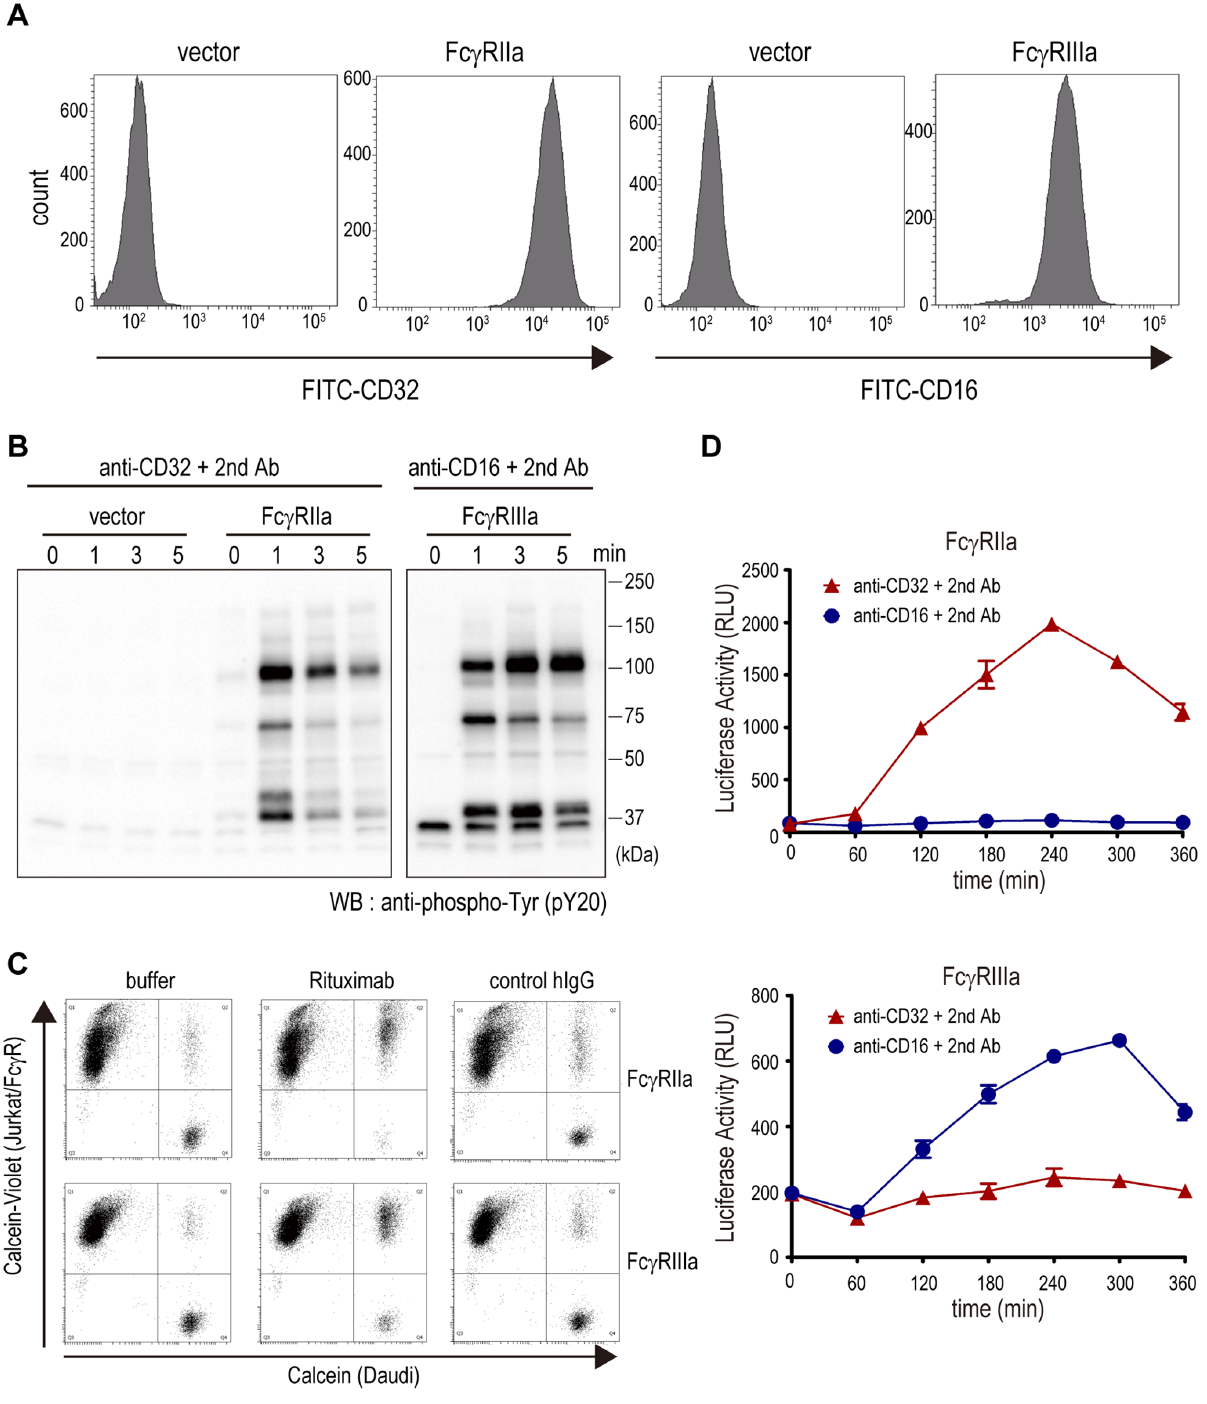
Figure 1. Establishment of the Fc c R-expressing reporter cell lines. (A) The cell surface expressions of Fc c Rs in Jurkat/Fc c R cells were analyzed by flow cytometric analysis. (B) The crosslinking of Fc c Rs by anti-Fc c R monoclonal antibodies induced the tyrosine-phosphorylated proteins in Jurkat/ Fc c R cells. (C) Bridging between calcein-labeled Daudi and calcein-violet-labeled Jurkat/Fc c R cells via rituximab was analyzed by flow cytometry. (D) The crosslinking of Fc c Rs by anti-Fc c R monoclonal antibodies induced the luciferase activities in Jurkat/Fc c R/NFAT-Luc cells. The assays were performed in triplicate, and the data are the mean 6 SEM. doi:10.1371/journal.pone.0095787.g001 initiation of ADCC. To assess the bridging ability of Jurkat/Fc c R that strongly expresses CD20, and calcein-violet-labeled Jurkat/ cells, we performed the flow cytometry-based bridging assay. Fc c R cells were co-incubated with or without an anti-CD20 mAb Calcein-labeled Daudi cells, a human Burkitt’s lymphoma cell line (rituximab) and analyzed by flow cytometry.